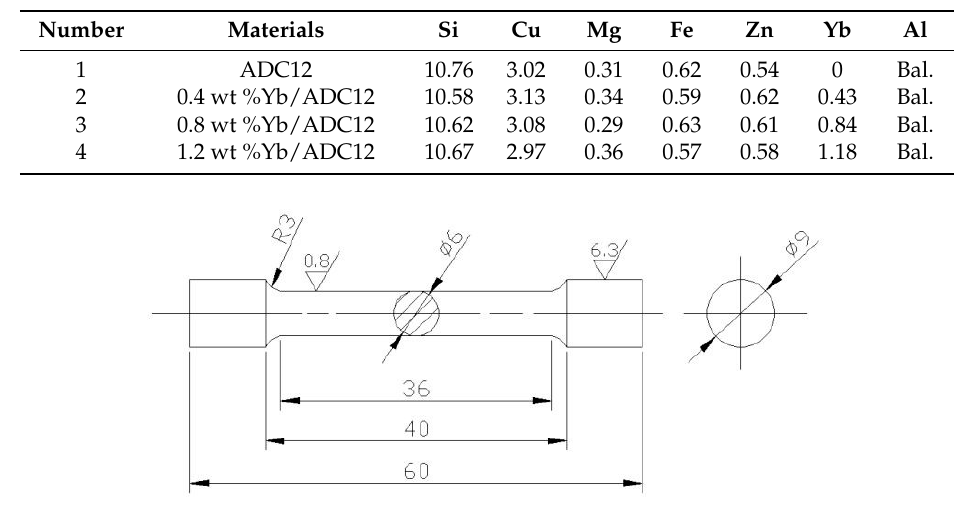
Figure 1. Schematic diagram of the standard tensile specimen (unit: mm).